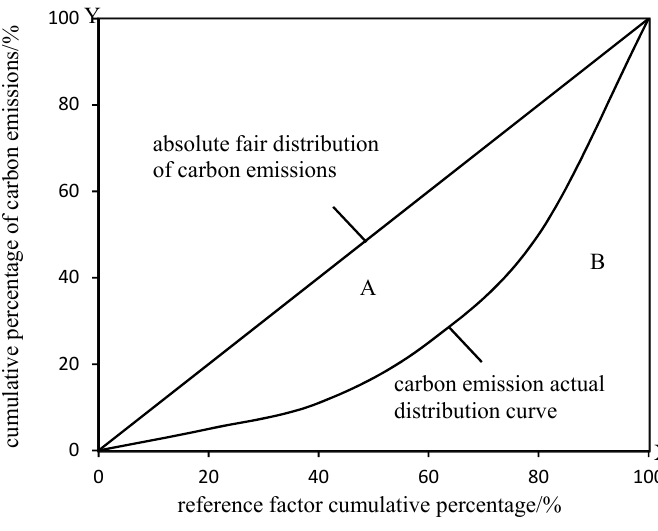
Figure 2. Carbon emission Lorenz curve.